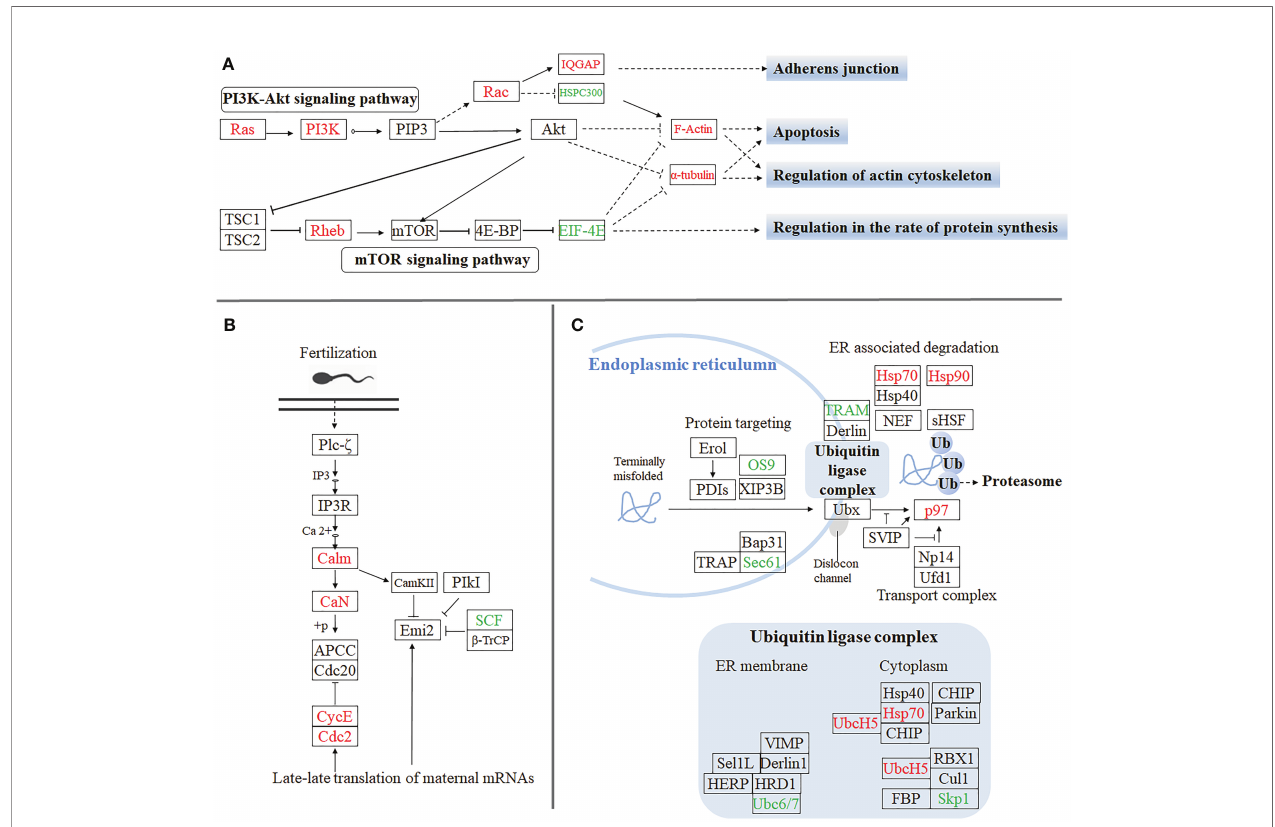
FIGURE 3 | The signi fi cant differentially expressed unigenes enriched KEGG pathway analysis by the comparative transcriptomic analysis of MroDmrt11E knockdown. Four kinds of categories with a higher percentage of upregulated and downregulated transcripts were primarily focused on the pathways of apoptosis and regulation of actin cytoskeleton (A) , oocyte meiosis (B) , and protein processing in endoplasmic reticulum (C) , respectively. The primary upregulated transcripts (red color) and the downregulated transcripts (green color) were brie fl y pro fi led in the various signaling